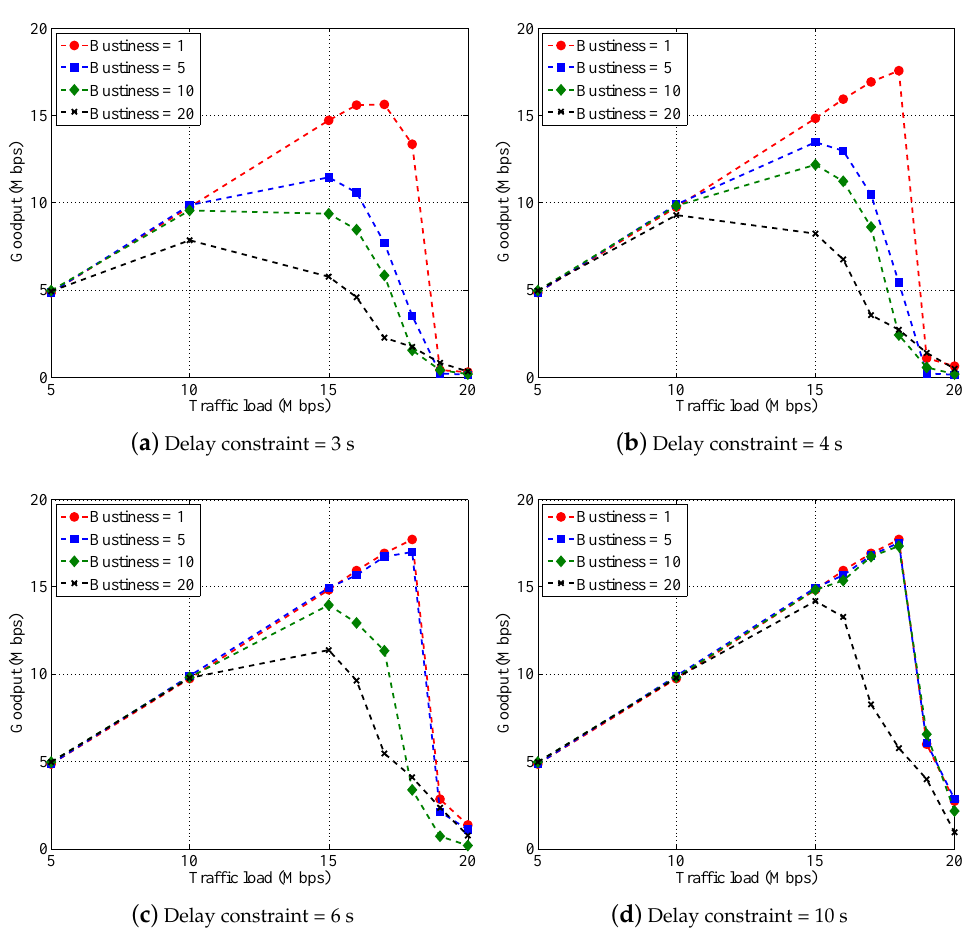
Figure 7. The goodput when the spectral efficiency is 3 bps/Hz when the traffic load varies from 5–20 Mbps and burstiness varies from 1–20